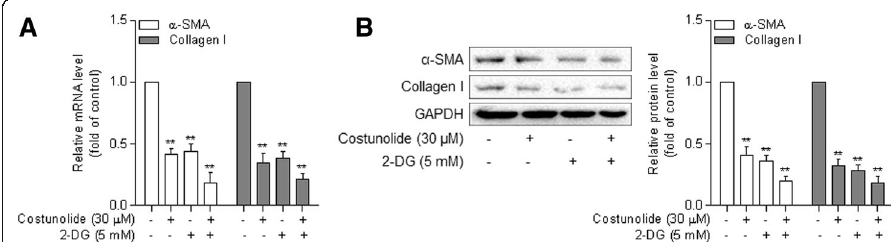
Fig. 3 Blockade of aerobic glycolysis contributes to the reduction in HSC activation by costunolide. Primary rat HSCs at passages 3 through 5 were treated with costunolide and/or 2-DG at the indicated concentrations for 24 h. a – Real-time PCR for determining the mRNA expression of α -SMA and collagen I. b – Western blot assay for determining the protein expression of α -SMA and collagen I with quantification of the blots. Statistics: ** p < 0.01 vs.